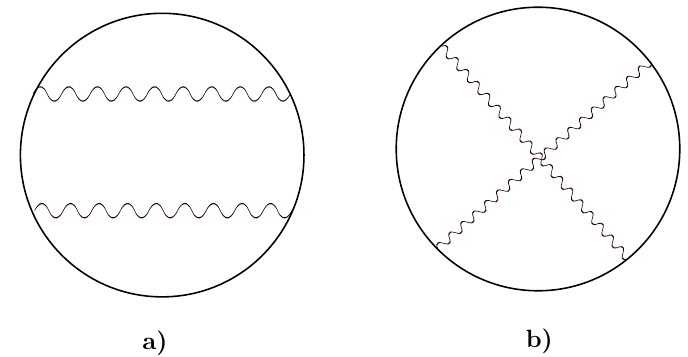
Figure 6 . Disconnected and connected Witten diagrams in the dual AdS 2 description. The discon- nected piece corresponds to a mean-(cid:12)eld theory correlator, while the connected piece is bootstrapped in the current